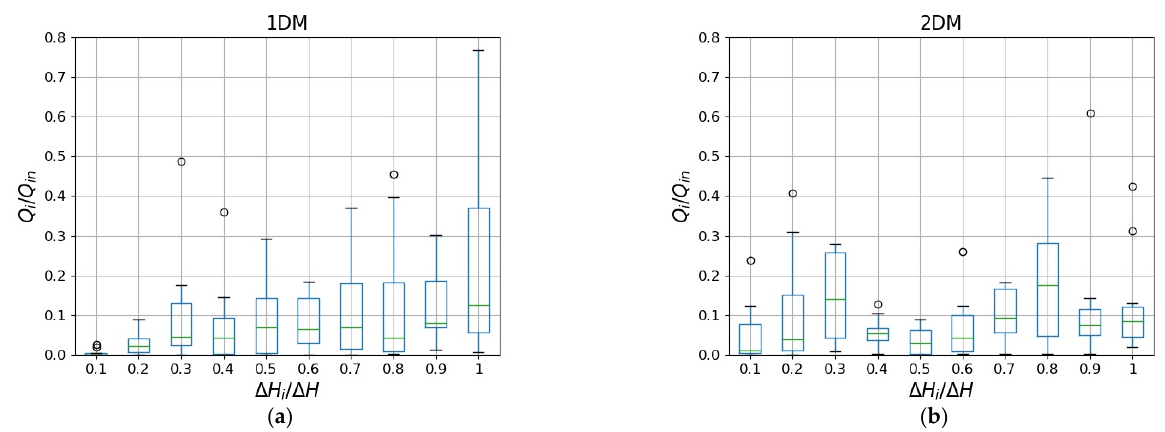
Figure 8. Boxplots of normalized demand distribution ( Q i / Q in ) vs. normalized head loss distribution ( ∆ H i / ∆ H ), where ( a ) is for networks with 1 inlet and ( b ) is for networks with 2 inlets. Circles show the outliers.